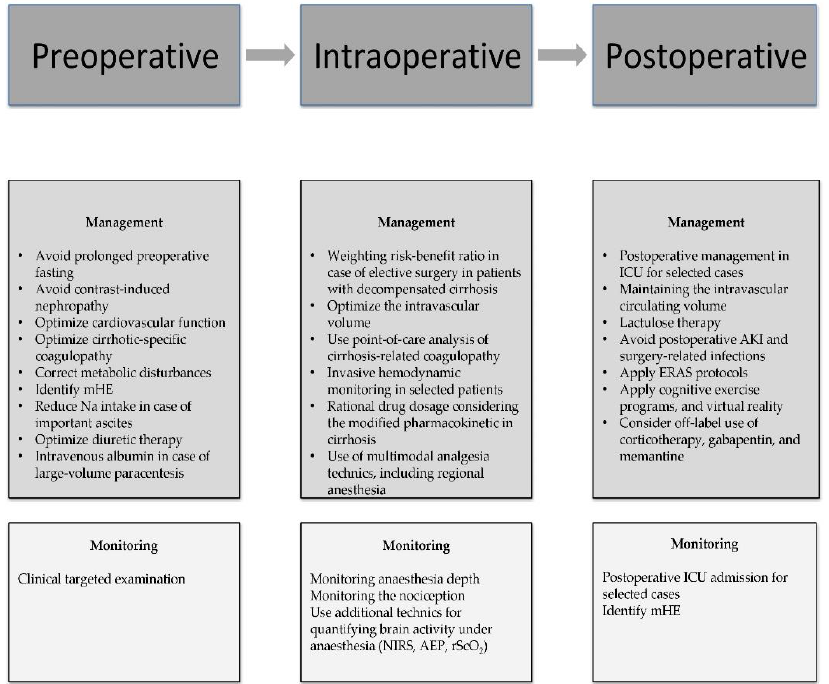
Figure 4. The main perioperative strategies for reducing POCD in cirrhotic patients. Abbreviations: mHE—minimal hepatic encephalopathy, NIRS—near-infrared spectroscopy, AEP—auditory evoked potentials, rScO 2 —the regional cerebral oxygen saturation, ICU—Intensive care unit, AKI—acute kidney injury, ERAS—early recovery after surgery.